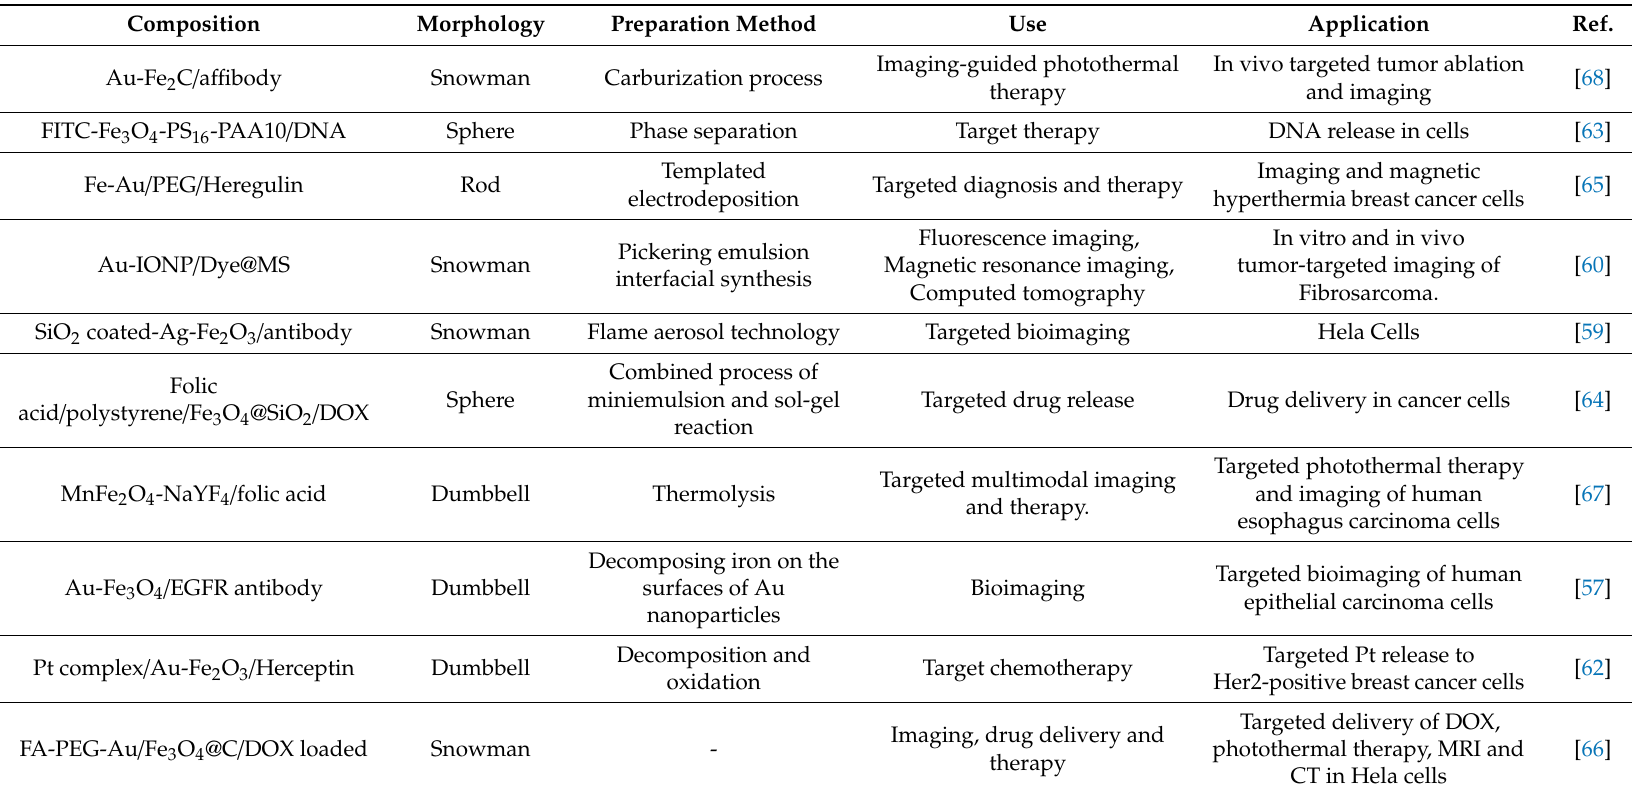
Table 2. Janus magnetic particles for targeted (bio)imaging and biomedical